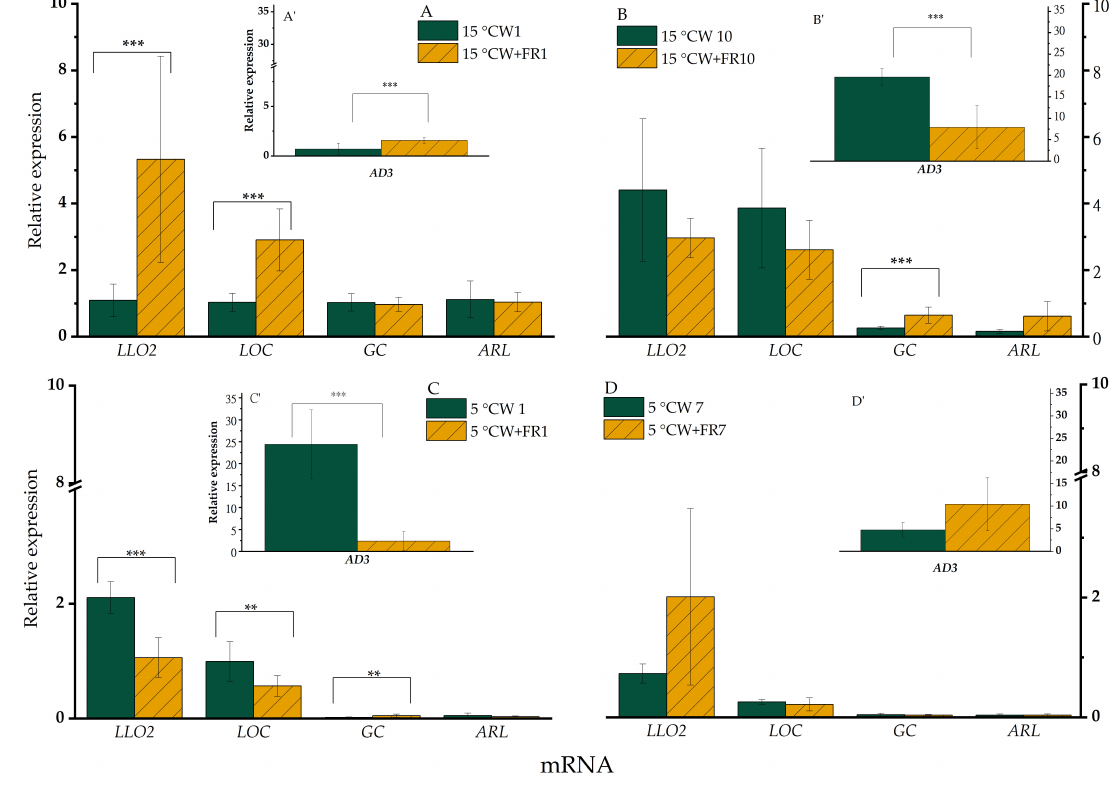
Figure 3. mRNA relative expression of barley “Nure” leaves grown at 15 ◦ C for 1 day ( A , A’ ) and for 10 days ( B , B’ ), and leaves grown at 5 ◦ C for 1 day ( C , C’ ) and for 7 days ( D , D’ ), under WL and WL + FR. Significance level was determined from 9 independent biological replicates and is designated as ** p < 0.05, *** p <